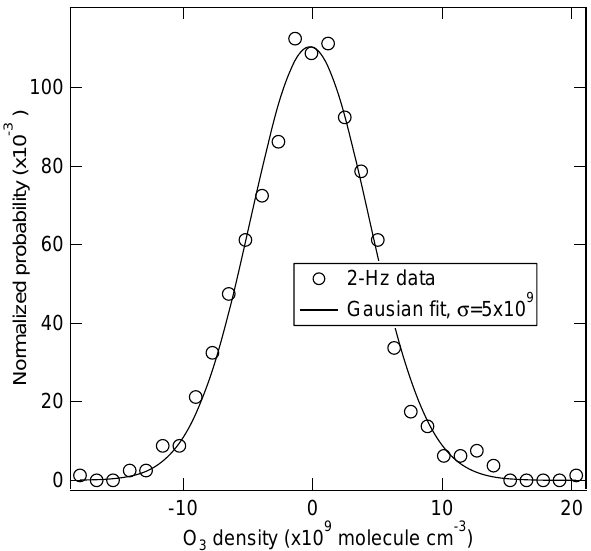
Fig. 6. NOAA-2 O 3 instrument precision (2Hz, 1 σ ) as a func- tion of absorption cell pressure at a fixed sample volume flow of 20 LPM. The intrinsic instrument precision (no flow) is 5 × 10 9 moleculecm − 3